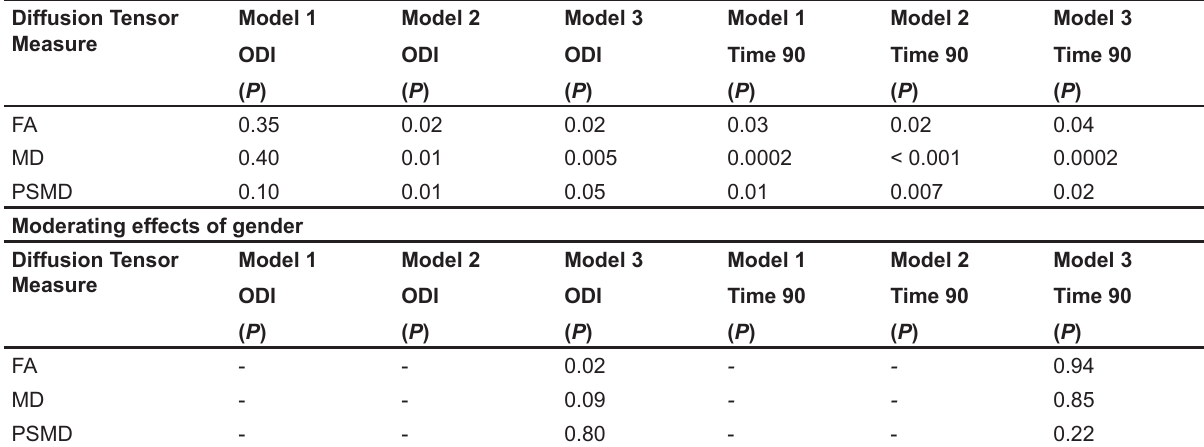
Table 6. Oxygenation and DTI measures Diffusion